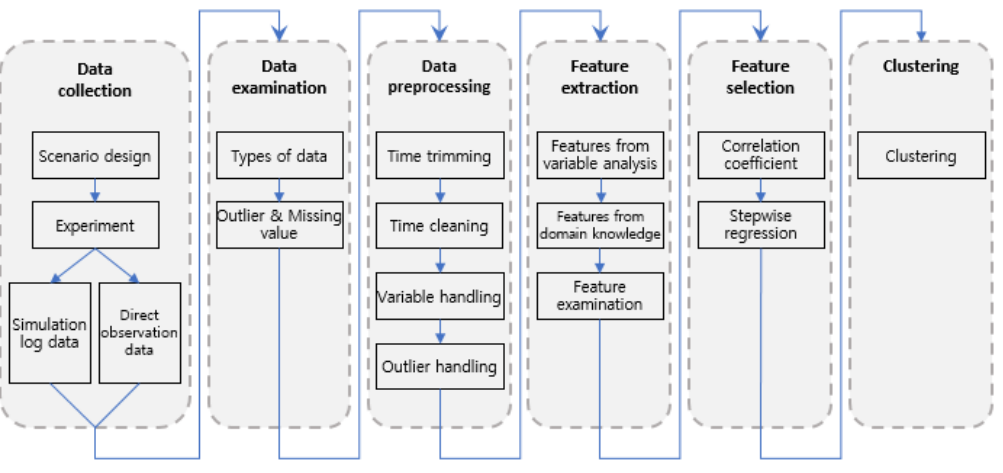
Figure 1. Workflow of the methodology.